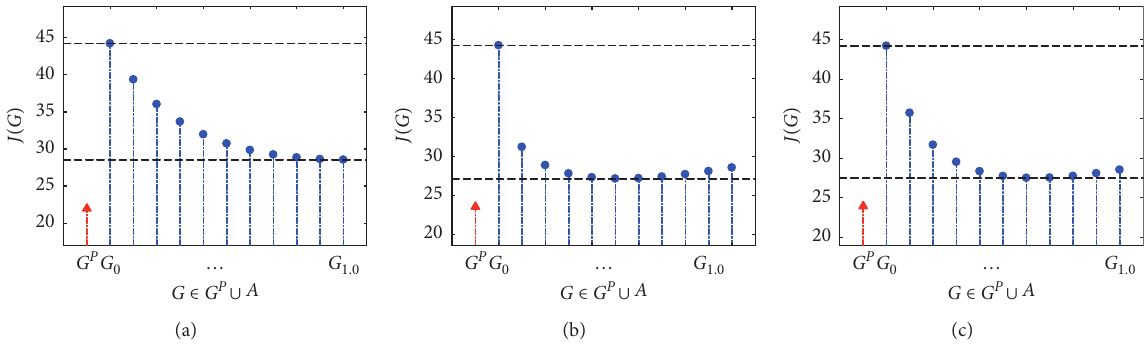
Figure 7: A comparison between the three promising controls G P in Figure 4 and the set of static controls A in terms of total cost.